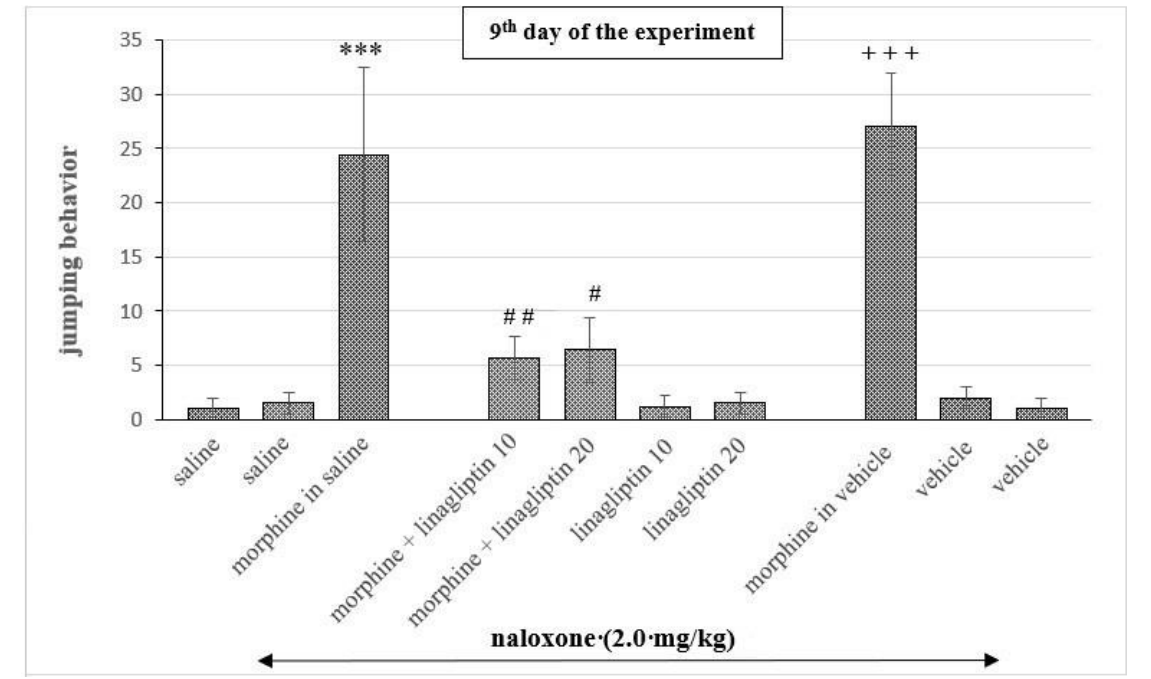
Figure 2. The effect of linagliptin (10 and 20 mg/kg, ip) on naloxone-induced morphine withdrawal, in mice. Morphine was administered for eight consecutive days (10, 15, 20, 25, 30, 35, 40 and 50 mg/kg), twice a day. On the 9th day, morphine (50.0 mg/kg) was first administered and 1 h later, naloxone (2.0 mg/kg, ip) was injected. The animals were immediately placed in glass cylinders and number of morphine jumping behaviors was recorded for 30 min. To study the effect of linagliptin on the acquisition of morphine withdrawal signs, linagliptin was administered once a day, for 8 days, 30 min before morphine injection (in the morning). The results are shown as the average number of jumping behaviors ± SEM. *** p < 0.001 vs. saline group, # p < 0.05, ## p < 0.01 vs. morphine in saline/in vehicle groups, +++ p < 0.001 vs. vehicle group; we observed no significant differences between saline vs. vehicle groups, saline + naloxone vs. vehicle + naloxone groups and morphine + naloxone + saline vs. morphine + naloxone + vehicle groups (Tukey’s test). 2.2. The Influence of Linagliptin (10 and 20 mg/kg, ip) Administered Simultaneously with Morphine on Depressive Behavior Observed in Mice, in the Forced Swim Test during: (A) Short-Term (60 h) and (B) Long-Term (14 Days) Morphine Withdrawal As the two-way ANOVA indicates, some significant changes were observed in the depressive behavior of the studied mice during short-term (morphine effect: F (1, 60) = 22.37, p < 0.0001; linagliptin effect: F (3, 60) = 0.451, p = 0.7175; interaction: F (3, 60) = 0.9911, p = 0.4032) and long-term (morphine effect: F (1, 61) = 19.88, p < 0.0001; linagliptin effect: F (3, 61) = 6.482, p = 0.0007; interaction: F (3, 61) = 1.220, p = 0.3101) withdrawal of morphine. It was